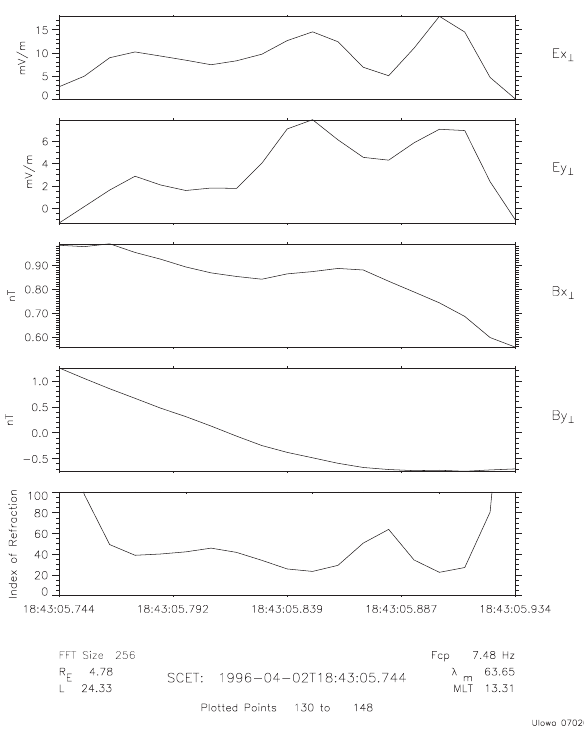
Fig. 2b. A higher resolution plot of perpendicular electric and mag- netic fields (first four panels) shown in Fig. 2a during the Alfv´en wave. In the bottom panel we plot the index of